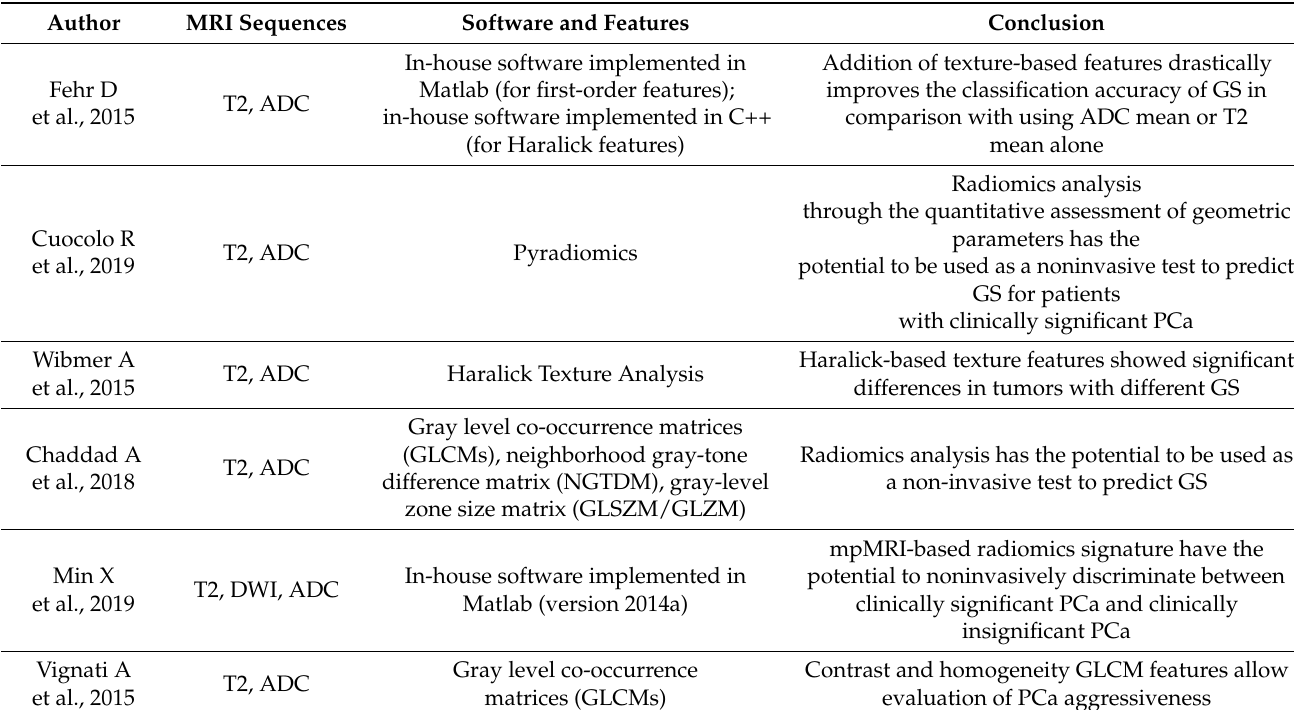
Table 2. Summary of radiomic manuscripts for prediction of Gleason